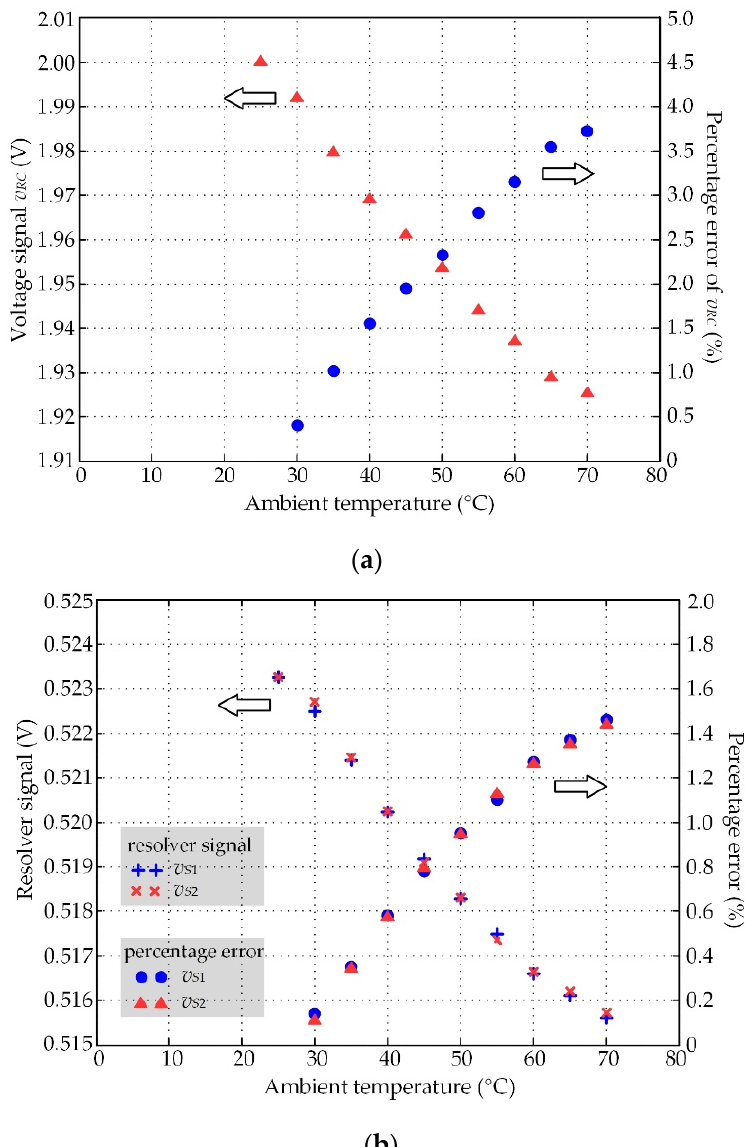
Figure 8. Measured results and percentage errors of resolver signals; ( a ) voltage signal v RC ; ( b ) re- solver signals v S 1 and v S 2 .